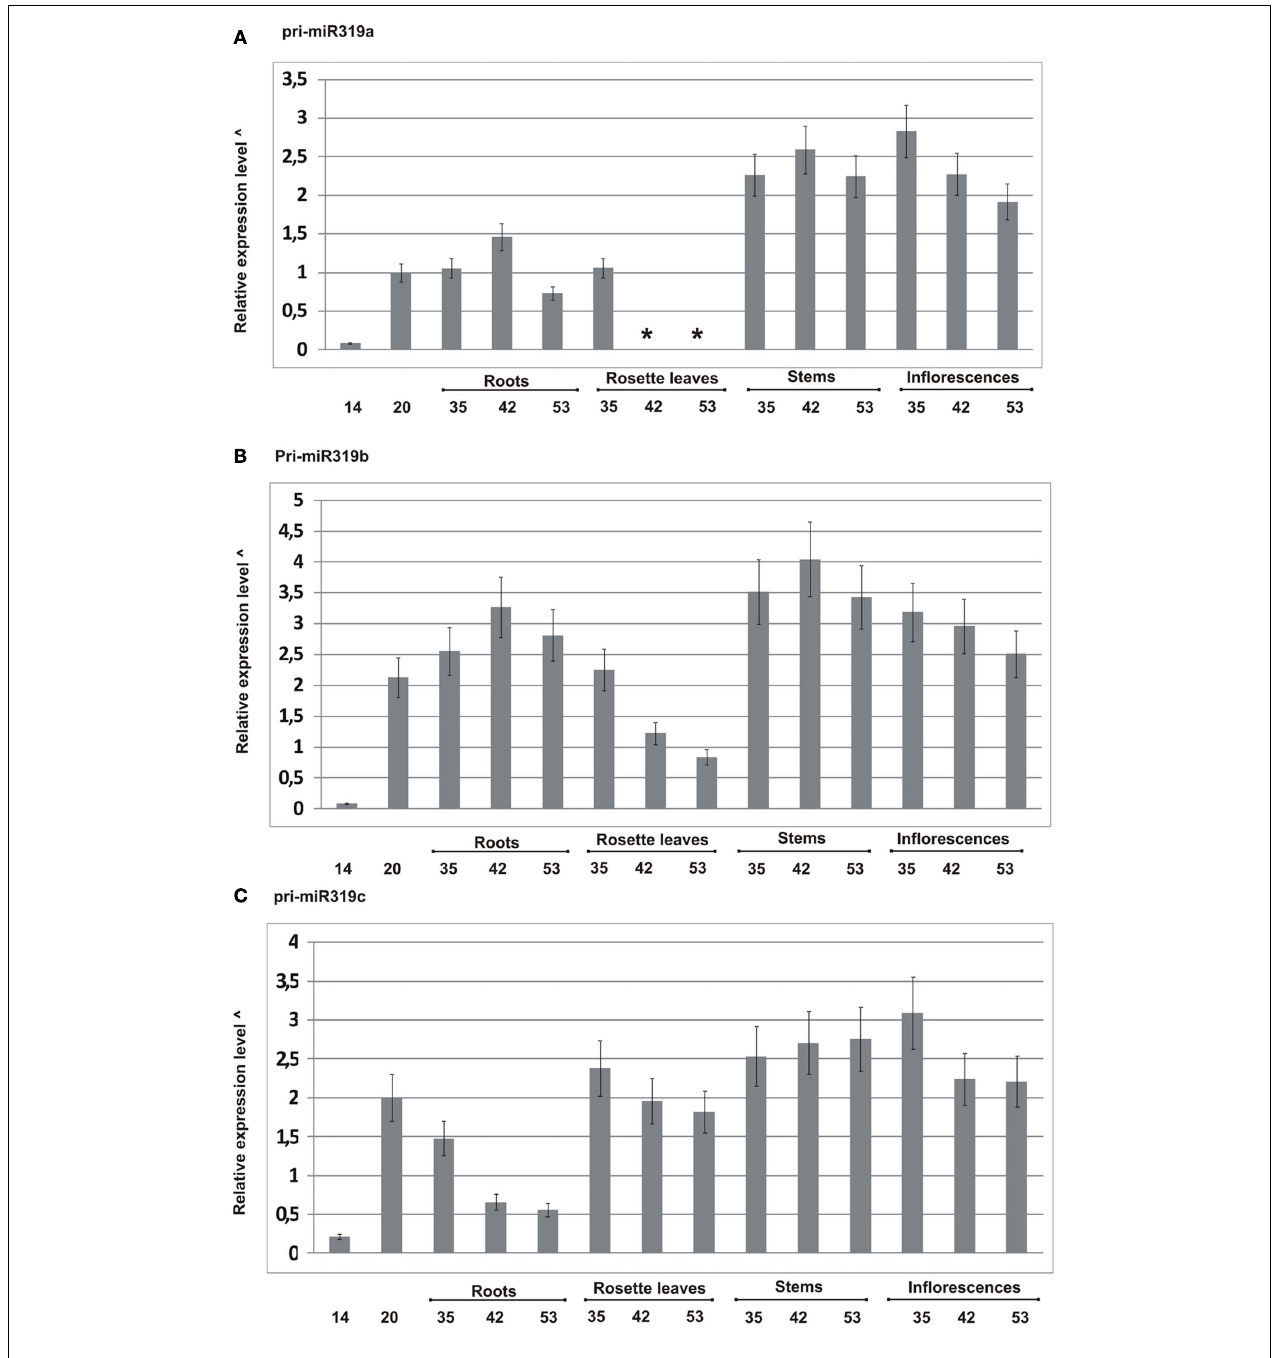
lower than the level of PP2A transcript, the graph was rescaled according to the following formula: abs (x max - x) , where abs denotes absolute value, x max represents the lowest integer value of relative expression level in the original graph and x represents actual expression level for a given pri-miRNA in the particular developmental stage. Real-time PCR for all pri-miR319 was carried out in three biological replicates.Thin black lines represent